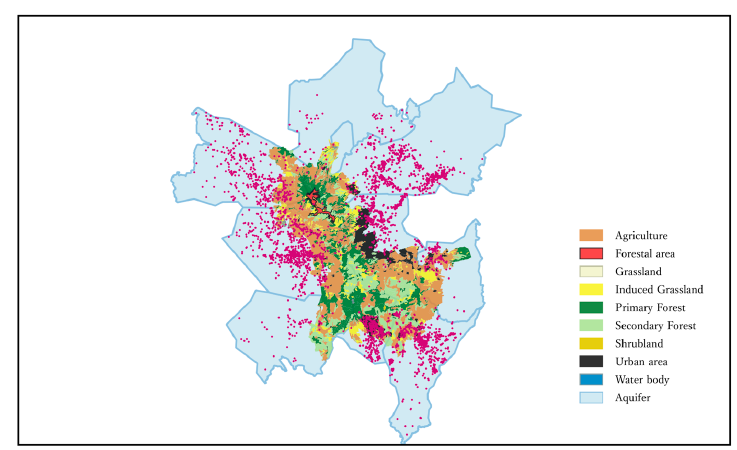
Figure 2. Land cover for the Water Forest region in the periods 1985–1996 ( top ), and 2008–2012 ( bottom ). Dots in the maps indicate the location of extraction wells. Source: own elaboration with data from INEGI (Series II) [81] and INEGI (Series V) [82].